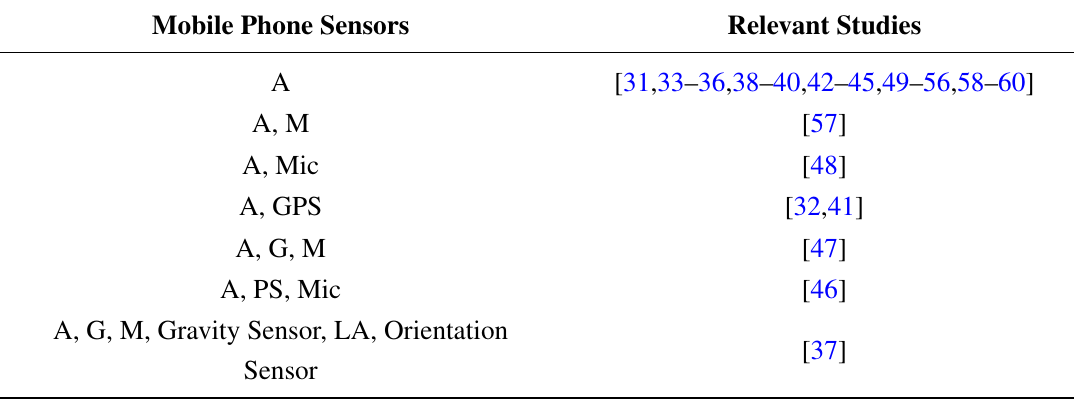
Table 5. Sensors used for online activity recognition. A, accelerometer; G, gyroscope; M,